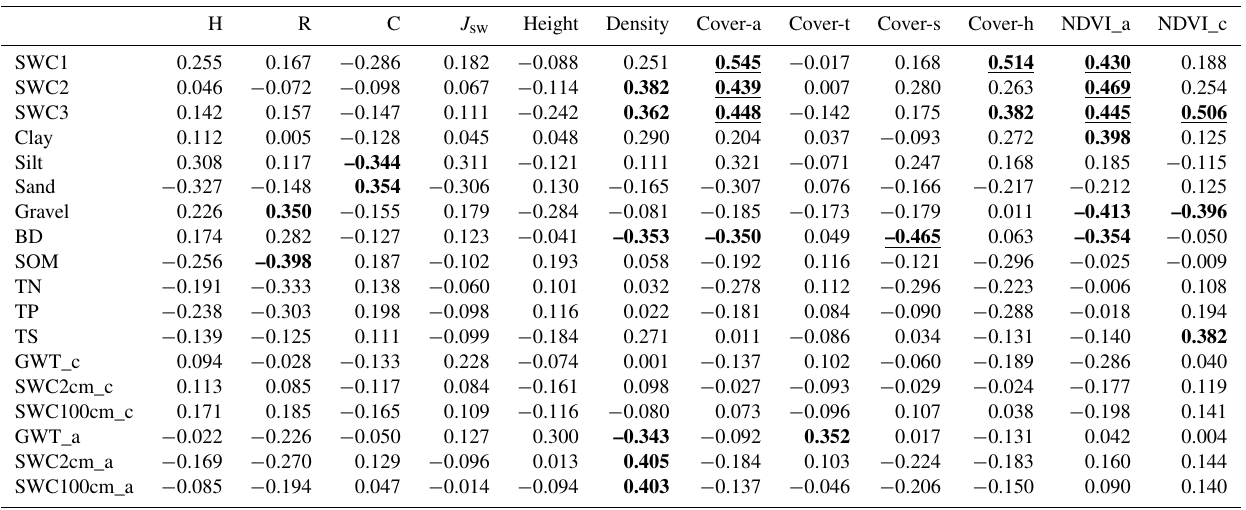
Table 1. Pearson correlations between community characteristics and environmental factors.